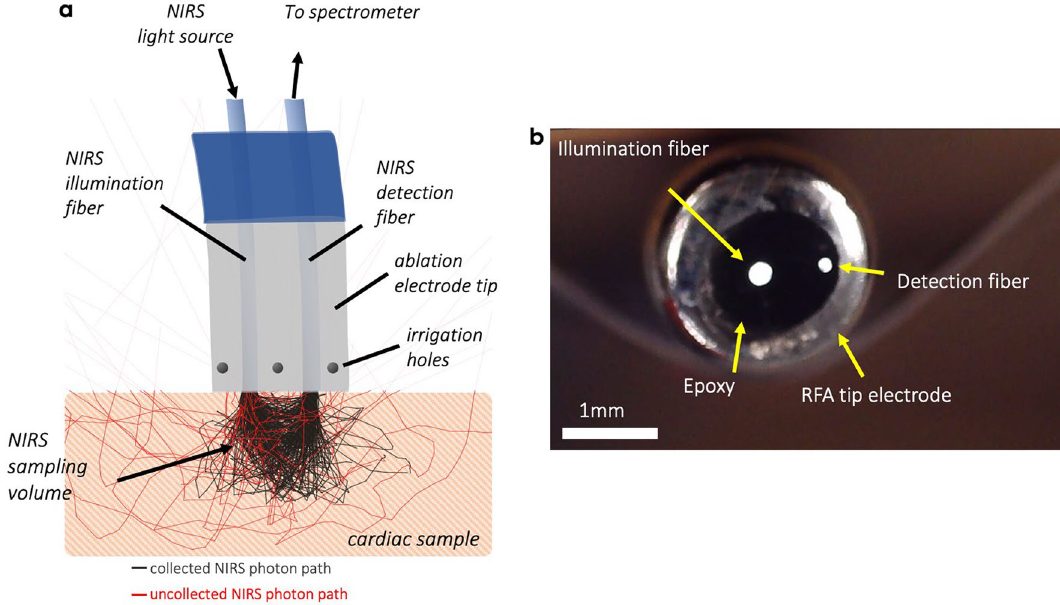
Figure 1. Combined NIRS radiofrequency ablation catheter. ( a ) Cartoon illustrating the concept of RF ablation catheters incorporating NIRS measurement and its salient features. ( b ) Finished catheter construction distal end showing embedded optical fibers for NIRS measurement at the tip